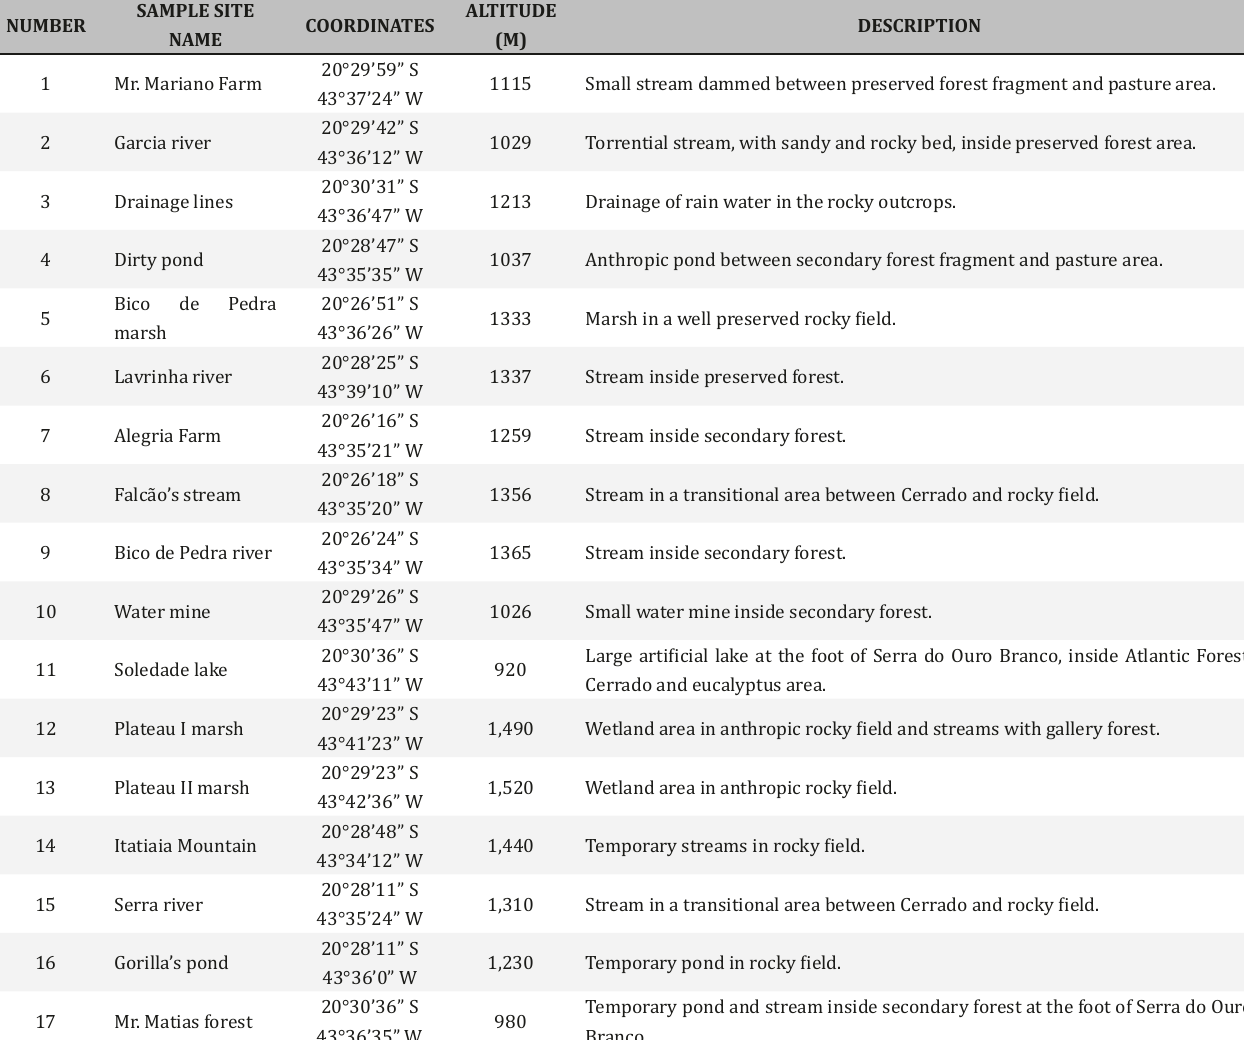
Table 1. Main sampled sites for anuran species in the region of Serra do Ouro Branco, south end of Espinhaço Range, Minas Gerais, southeastern